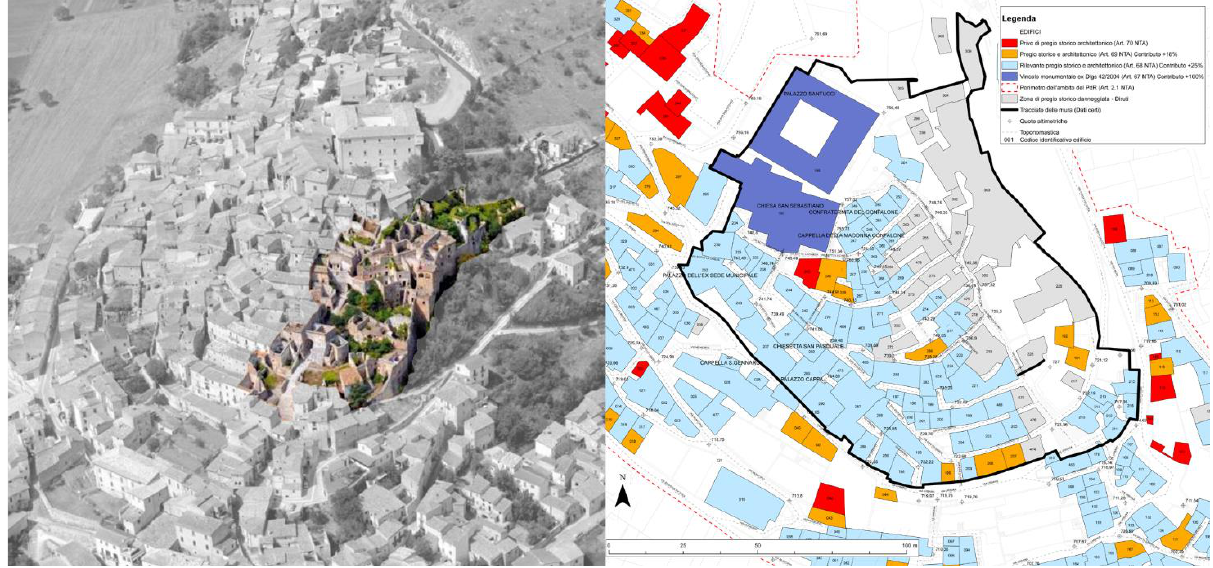
Figure 2. On the left: aerial view of Navelli with the case study zone highlighted; on the right: RdP chart focused on the area inside the ancient